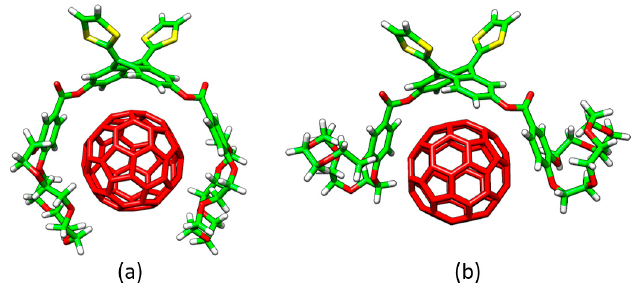
Figure 4. Minimum-energy embraced ( a ) and non-embraced ( b ) conformations calculated at the PM7 level for the 2• C 60 complex. The electron-acceptor C 60 is colored in red whereas the sulfur, carbon, oxygen and hydrogen atoms in the electron-donor system are colored in yellow, green, red and white, respectively.